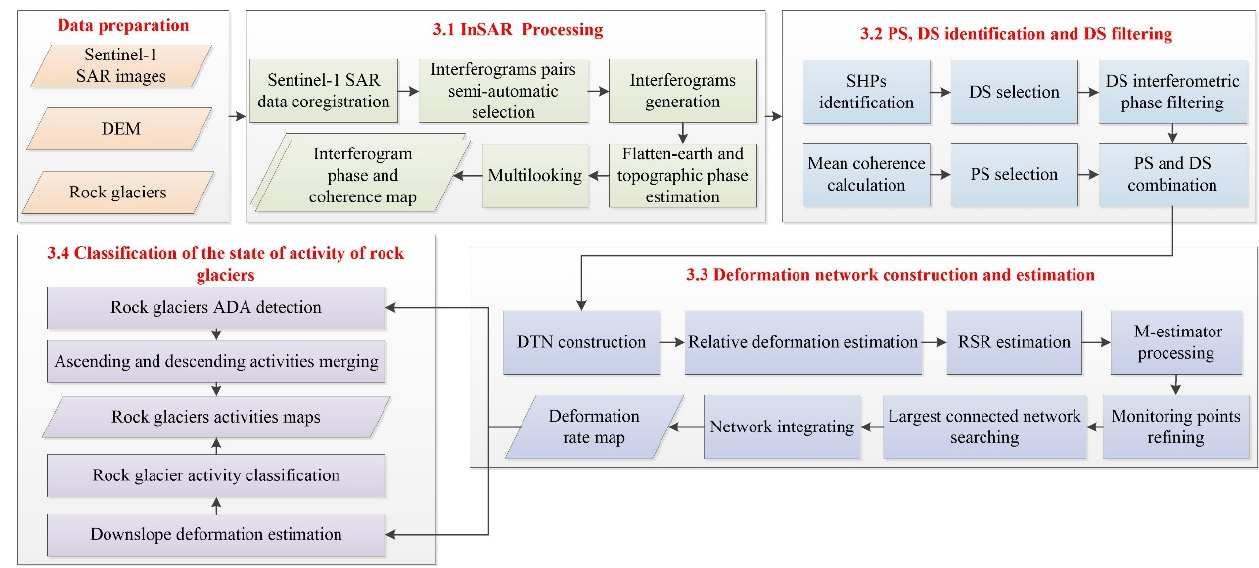
Figure 4. The flow chart of the multi-baseline persistent scatterer (PS)/distributed scatterer (DS) combined MT-InSAR approach and rock glacier activity classification (SHP indicates statistically homogeneous pixels, DTN indicates Delaunay triangular network, RSR indicates residue-to-signal ratio, ADA indicates active deformation area).